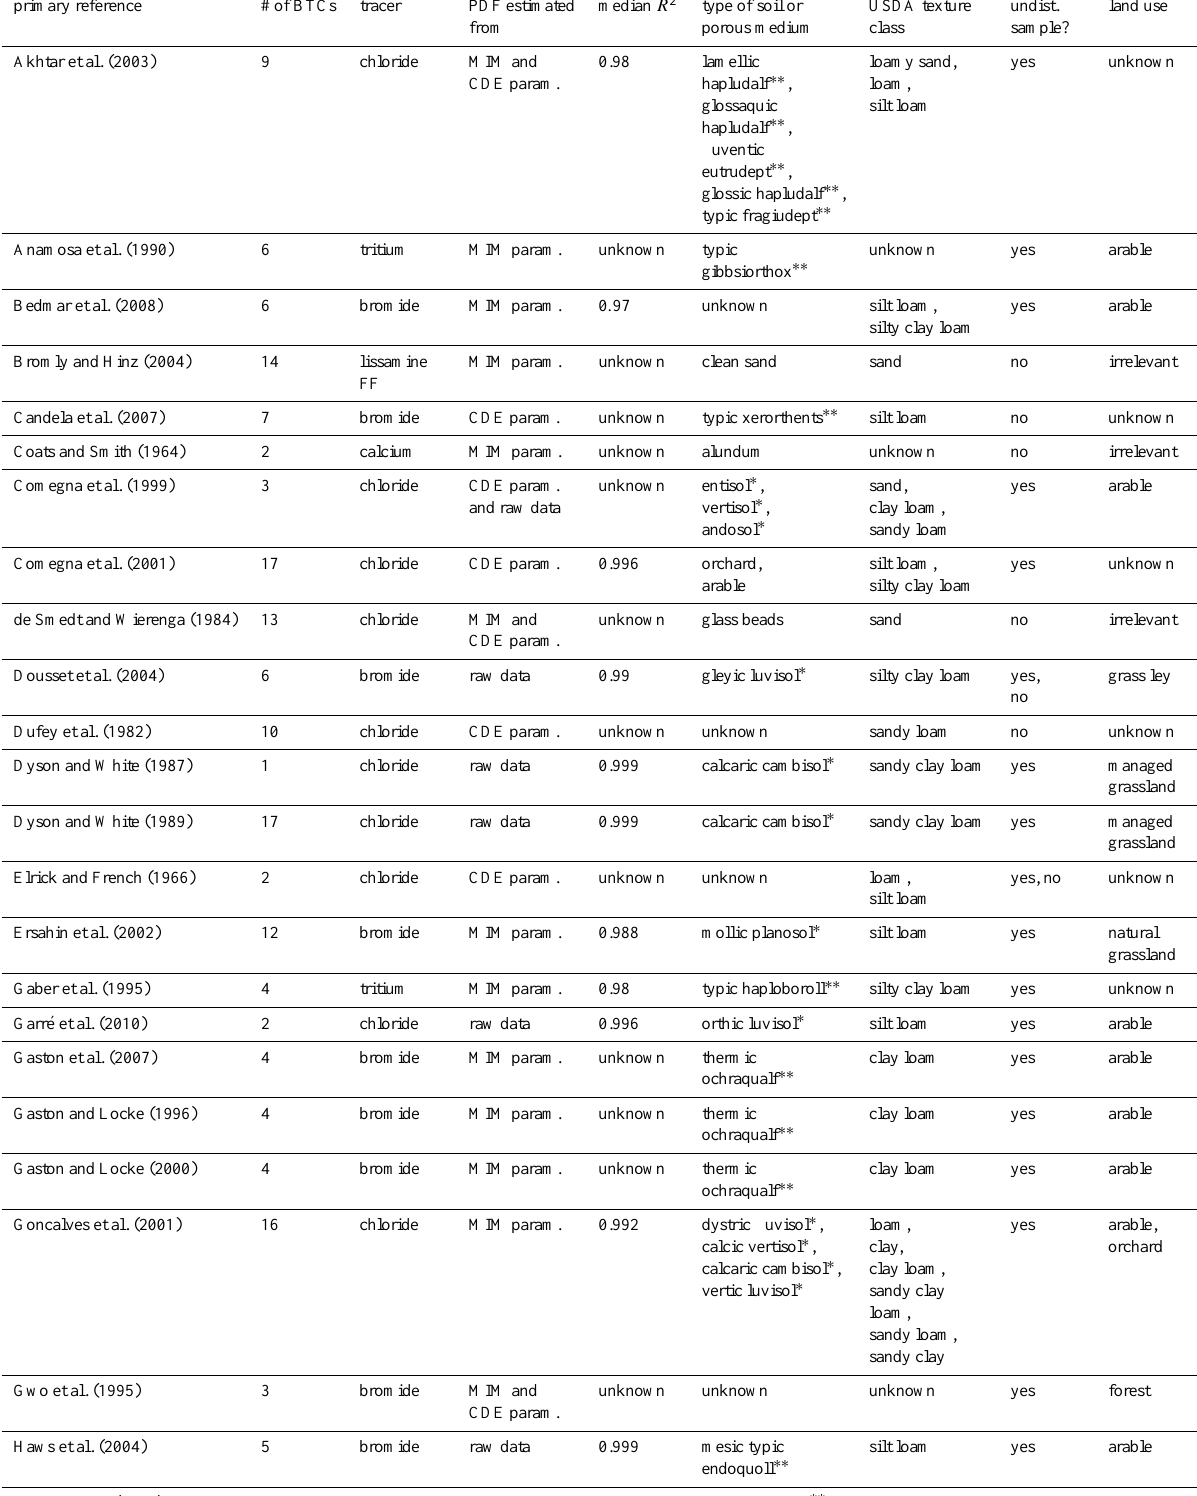
Table 1. Primary source publication and other information on the BTC experiments collected in the